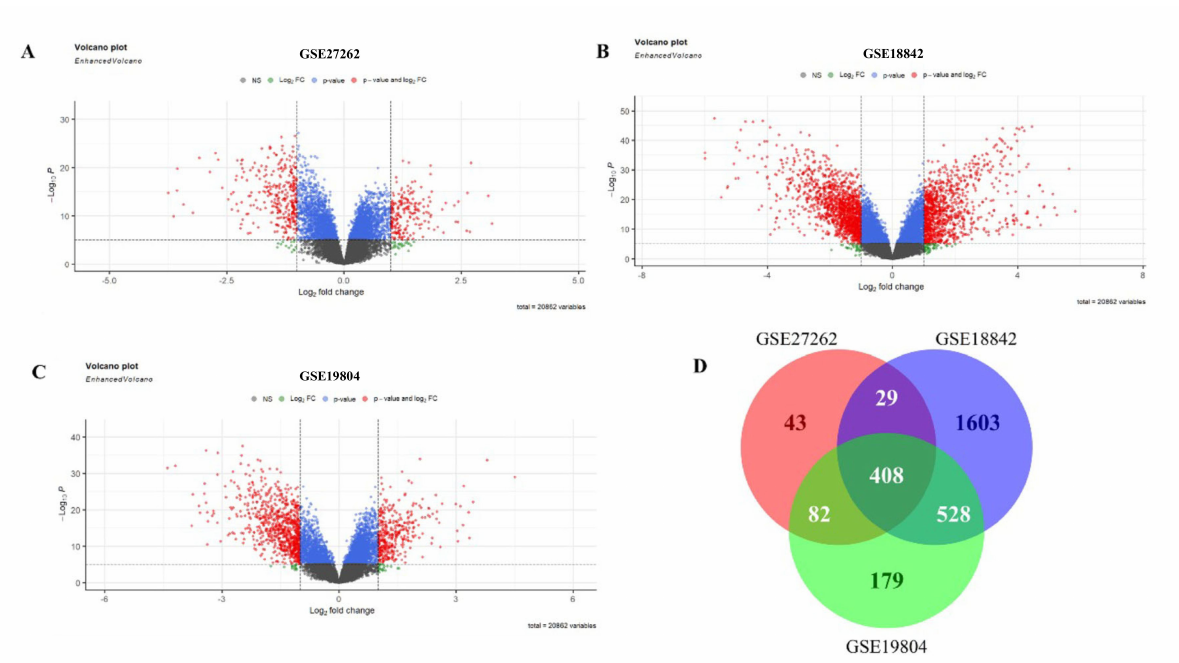
Figure 2. DEGs in the microarray dataset. ( A ): DEGs of GSE27262; ( B ): DEGs of GSE18842; ( C ): DEGs of GSE19804; ( D ): DEGs shared by 3 microarray